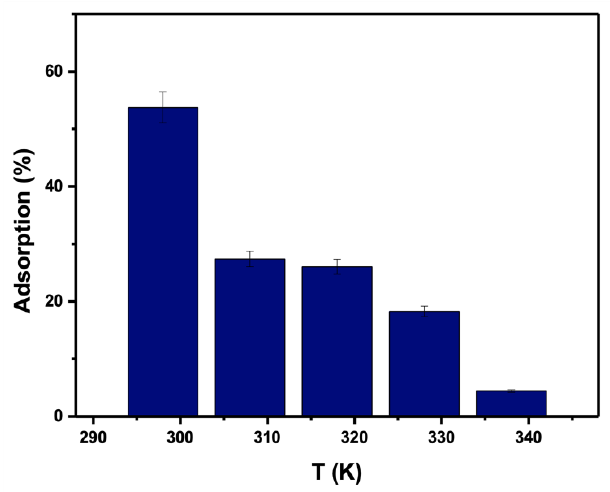
Figure 11. Effect of temperature of dye PTZS on adsorption by GO-date Seeds. (C o = 11 ppm, pH: 9, Adsorbent dosage: 0.05 g /L, Contact time: 30 min).